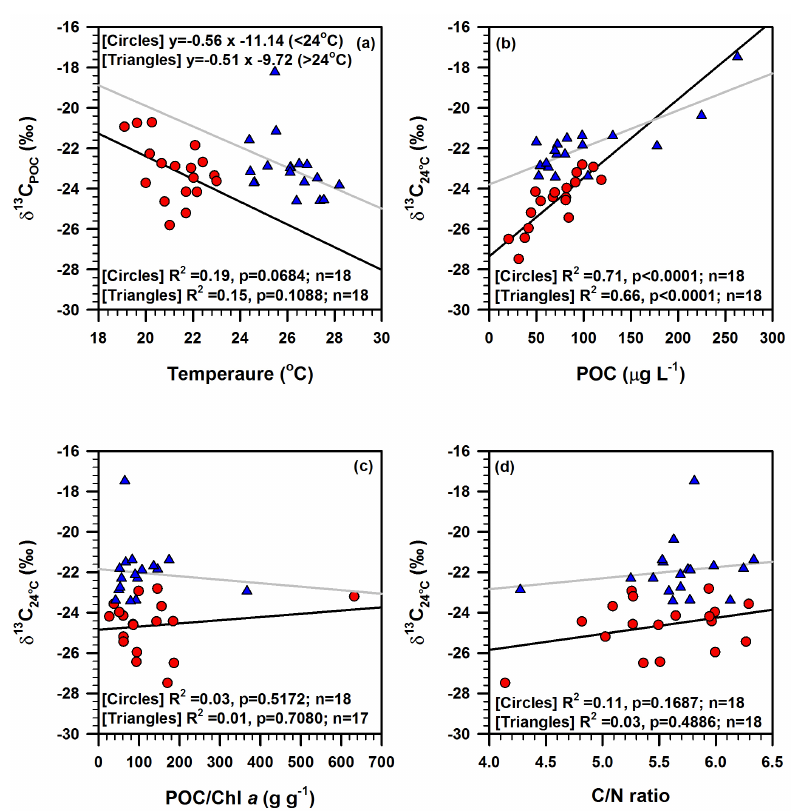
Figure 11. Bi-plots showing the relationships of (a) δ 13 C POC vs. temperature for samples separated into two groups based on tempera- ture: < 24 ◦ C and > 24 ◦ C, (b) temperature-normalized δ 13 C ( δ 13 C 24 ◦ C ) vs. POC concentration, (c) δ 13 C 24 ◦ C vs. POC / Chl a ratio, and (d) δ 13 C 24 ◦ C vs. molar C / N ratio in suspended particulate matter around deep chlorophyll maximum layers in the southern East China